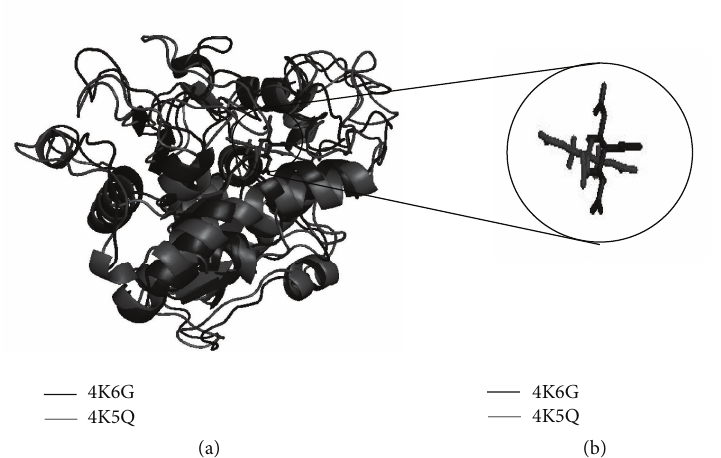
Figure 4: An illustration of the docked enzymes native CALB (4K6G) and mutant CALB (4K5Q) bound to their ligand triglyceride: (a) superimposed structure of the docked CALB and (b) the orientation of the ligand triglyceride at the active site